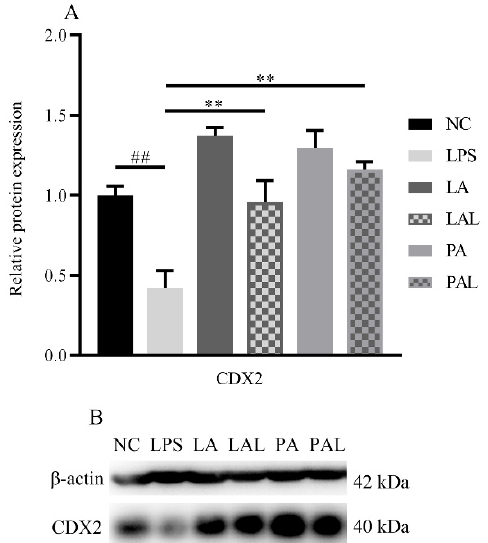
Figure 6. A. muciniphila mediated the expression of CDX2. ( A , B ) The protein expression of CDX2 in Caco-2 cells. ** p < 0.01, compared with LPS group. ## p < 0.01, compared with NC group. Data are expressed as mean ± S.D. ( n = 6). NC, control group. LPS, lipopolysaccharide-damaged group. LA, live A. muciniphila . PA, pasteurized A. muciniphila . LAL, live A. muciniphila + LPS. PAL, pasteurized A. muciniphila + LPS. CDX2, Caudal type homeobox 2.